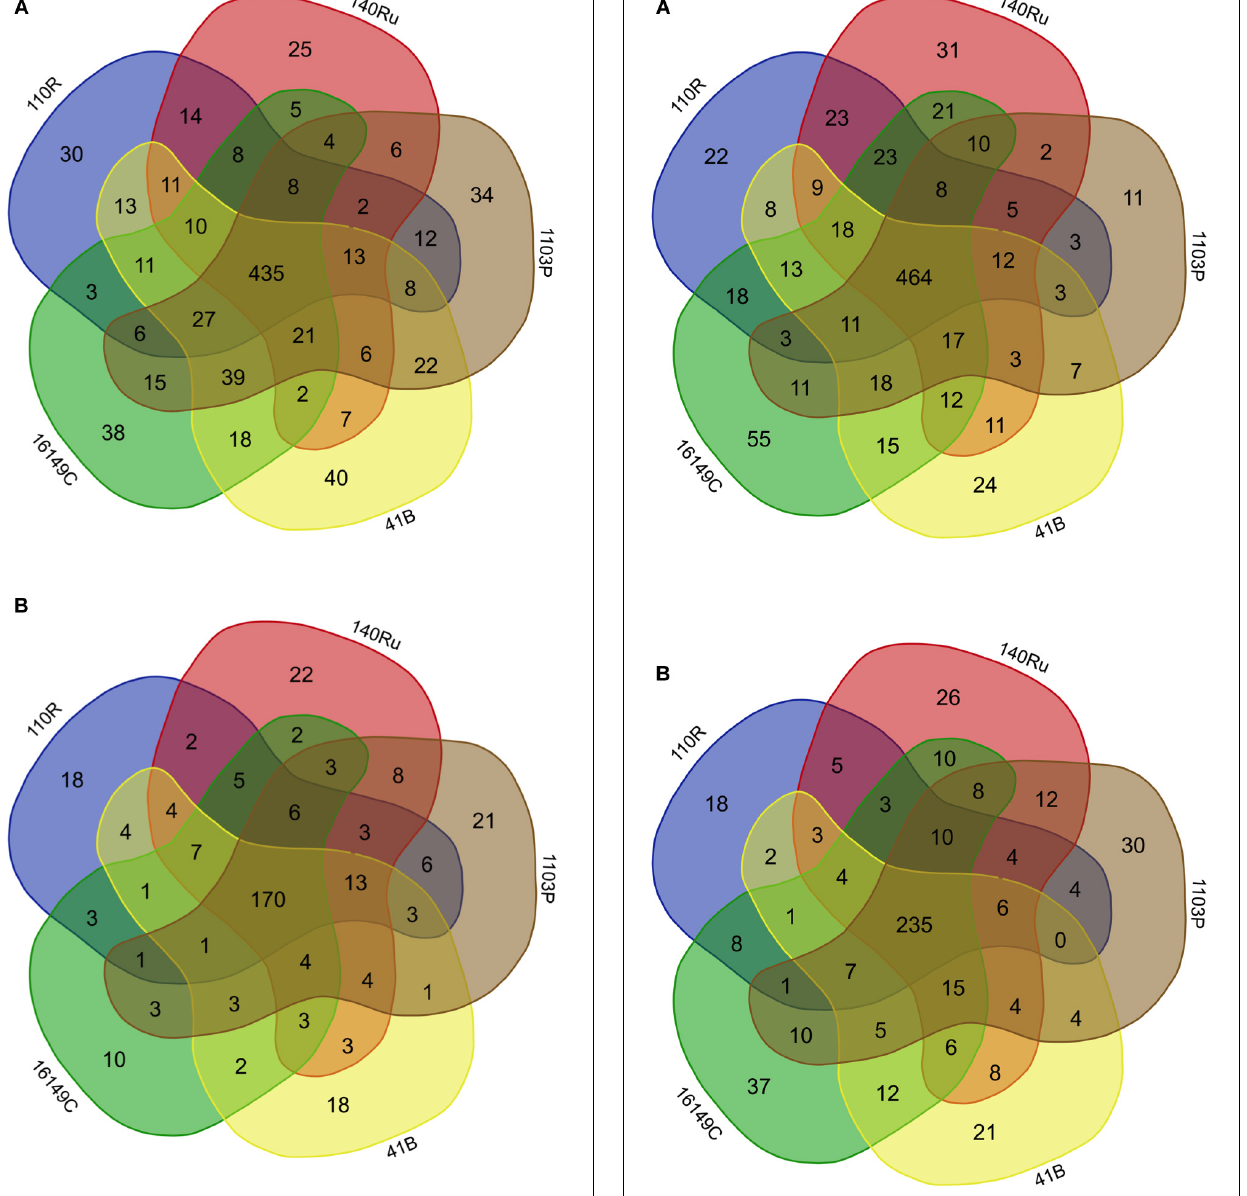
FIGURE 5 | Venn diagrams showing the common and exclusive bacterial (A) and fungal (B) OTUs of the rhizosphere of the grapevine rootstocks in Aldea vineyard.